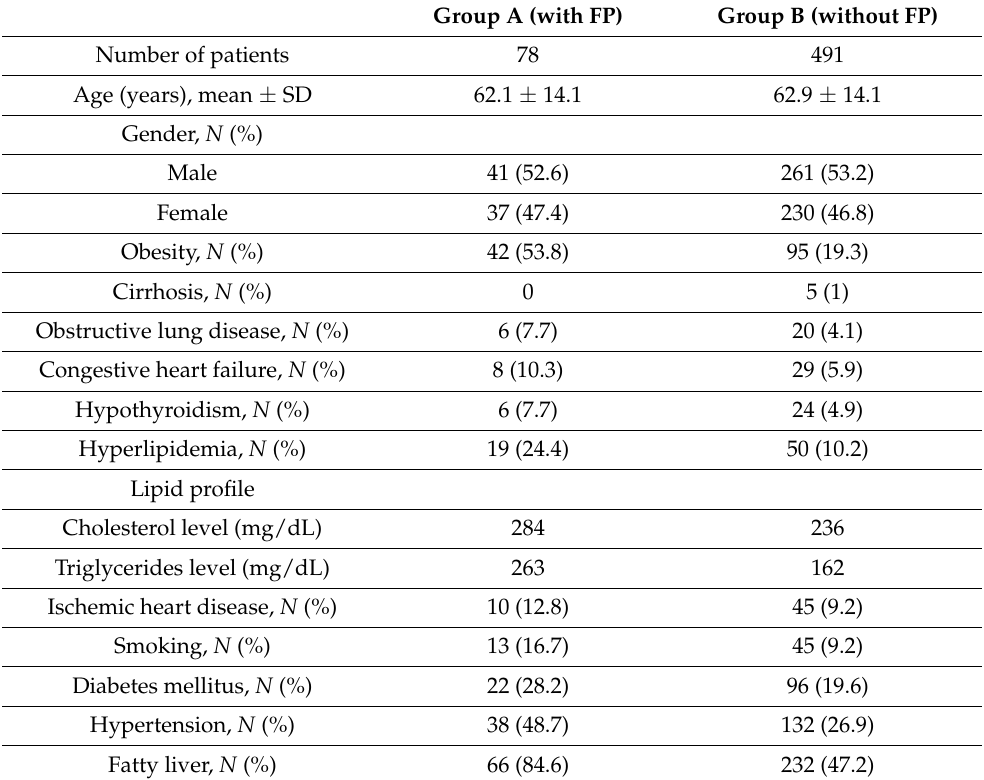
Table 1. Demographics and baseline characteristics. Group A (with FP) Group B (without